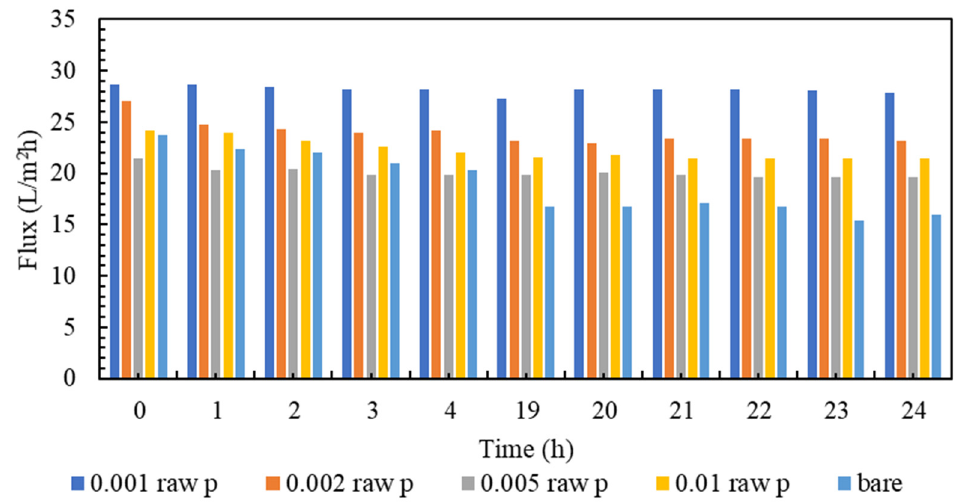
Figure 7. A comparison of Fouling flux of the modified membranes to the bare one.